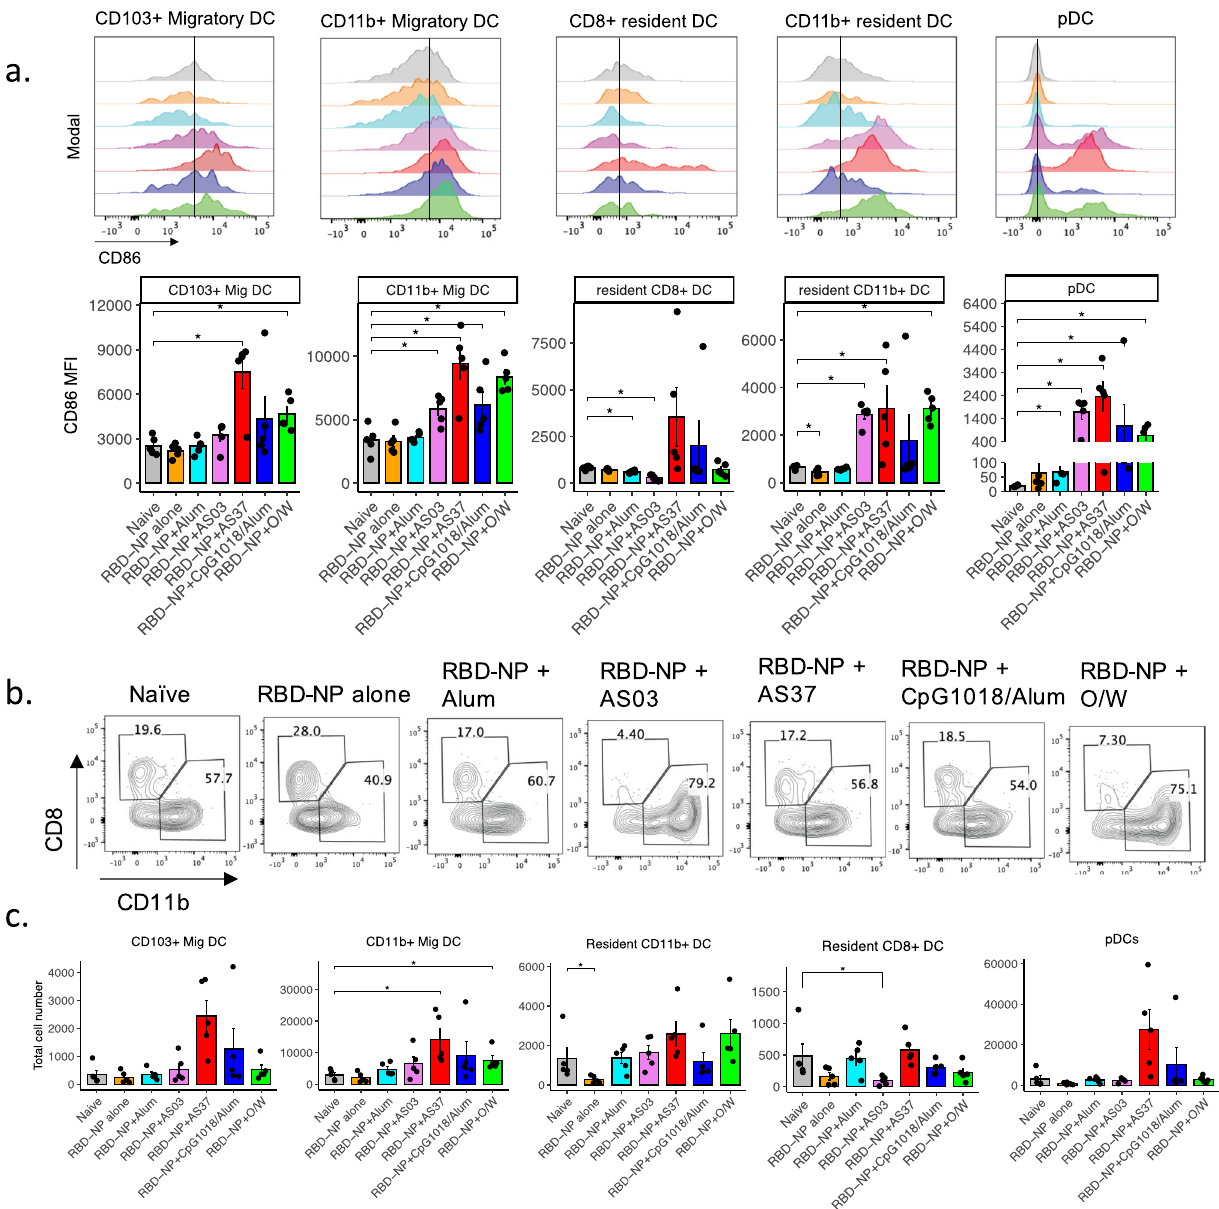
Fig. 4 Activation of DC subsets in response to immunization with RBD-NP and adjuvants. a CD86 MFI of dendritic cell subsets in the draining iliac lymph nodes 24 h post-immunization. b Representative fl ow cytometry plot for CD8 + DCs and CD11b + DCs (gated on resident DCs). c Total cell numbers of dendritic cells subsets in the iliac lymph nodes 24 h post-immunization. a – c Data representative of 3 in dependent experiments with n = 5 mice per group. P -values: * denotes p < 0.0332, ** p < 0.0021, *** p < 0.0002, and **** p < 0.0001. Error bars indicate mean ± SEM in all